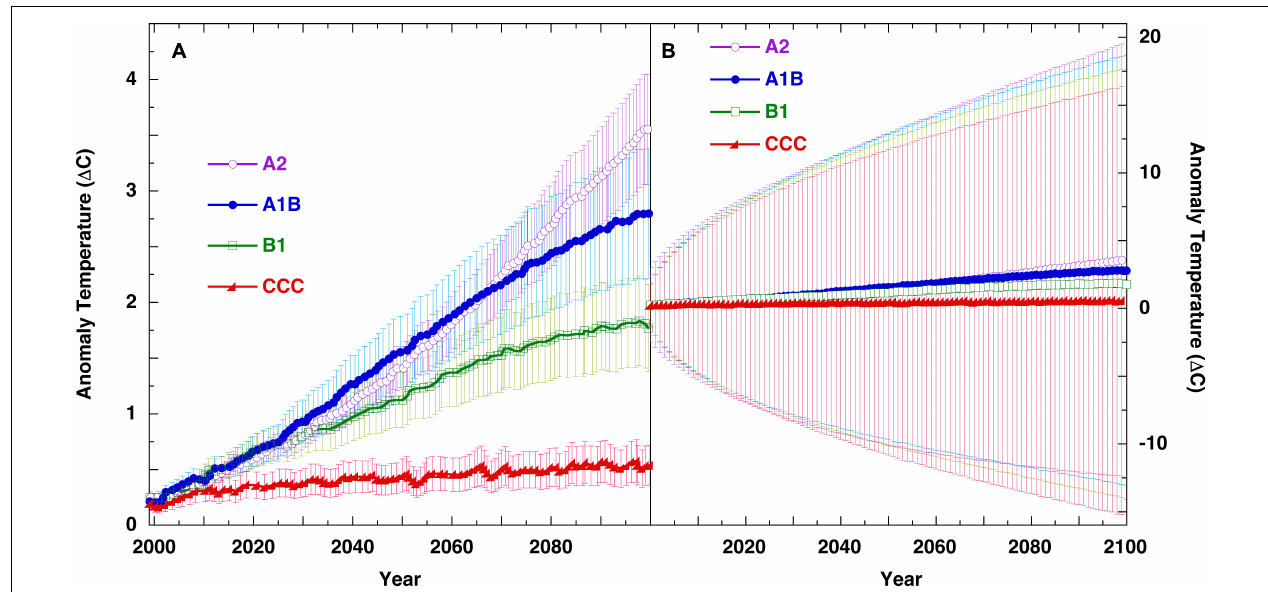
FIGURE 6 | Panel (A) , SRES scenarios from IPCC 4AR WGI Figure SPM.5 (IPCC, 2007), with uncertainty bars representing, “ the ± 1 standard deviation range of individual model annual averages. ” Panel (B) the identical SRES scenarios showing the ± 1 σ uncertainty bars due to the annual average ± 4 Wm − 2 CMIP5 TCF long-wave tropospheric thermal flux calibration error propagated in annual steps through the projections as equation 5 and equation 6.